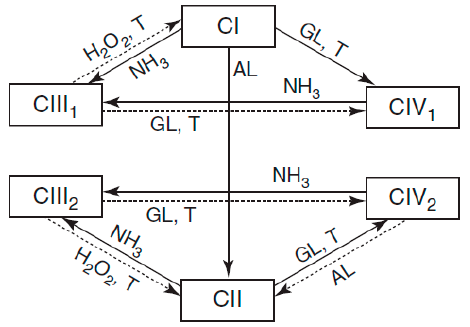
Figure 8. Scheme of transitions between various polymorphic crystalline forms of cellulose CI (native cellulose), CII (cellulose), CIII1 and CIII2 (cellulose III1 and III2), and CIV1 and CIV2 (cellulose IV1 and IV2) [58].